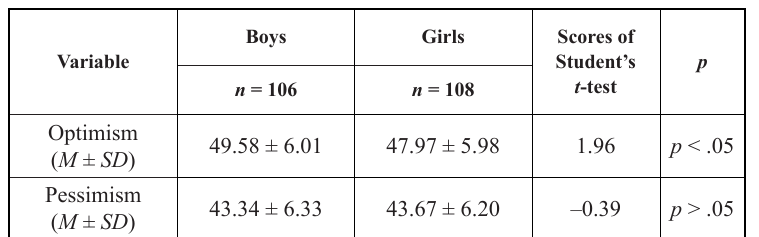
Note. ( M ± SD ) – mean and standard deviation.